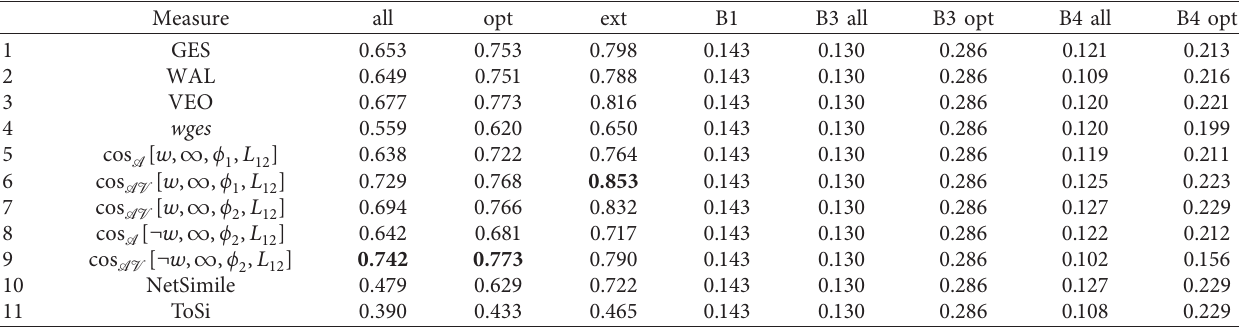
Column “all”: F -scores, if all features are used by the similarity measure (row). Column “opt”: F -scores, if a subset of features selected by the genetic search is used. Column “ext”: F -scores, if a subset of features selected by the extended genetic search is used. The last five columns display the F -scores of the random baselines B1, B3, and B4, in the case of B3 and B4 differentiated for the variants all and opt Table 7: F -scores of classifying ATNs into five classes (C ITIES , R EGIONS , O THERS , WP-R EGIO -1, and WP-O THERS -1) by means of SVMs using RBF kernels.